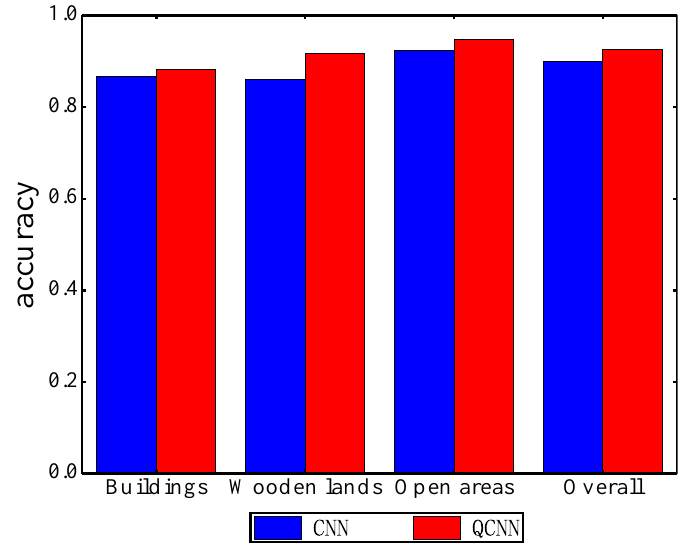
Figure 17. The classification accuracies by CNN and QCNN on Oberpfaffenhofen data